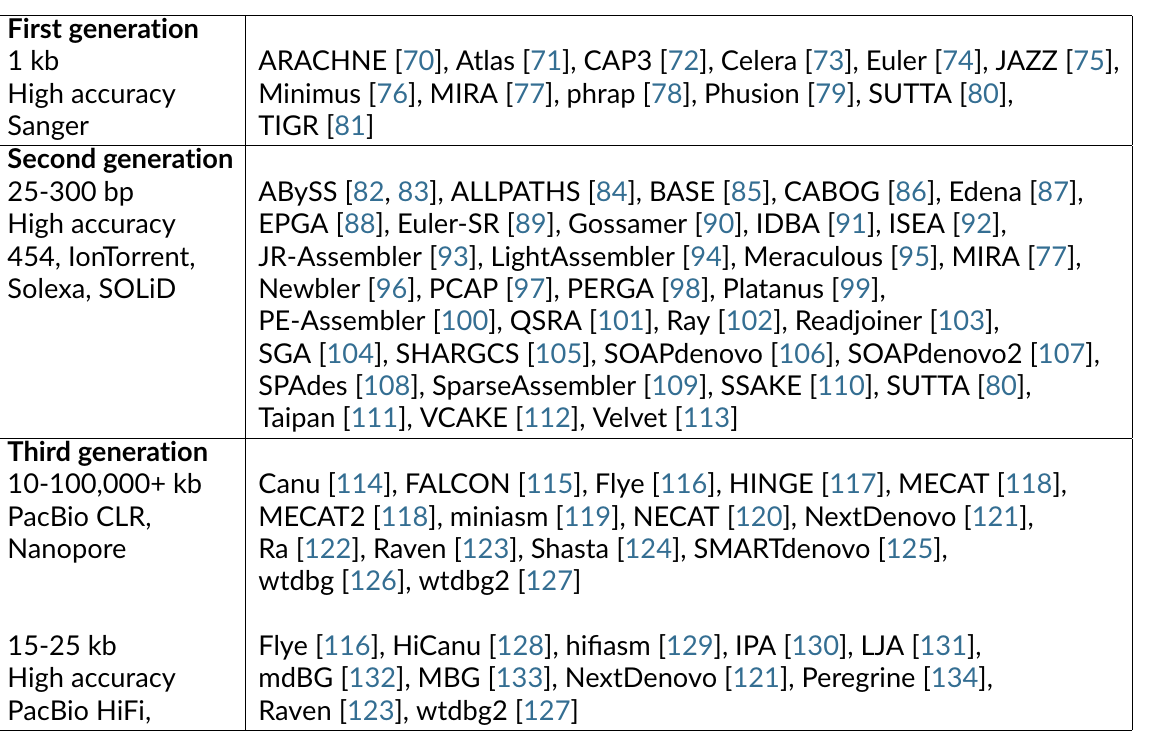
Table 1 – Sequencing approaches and associated